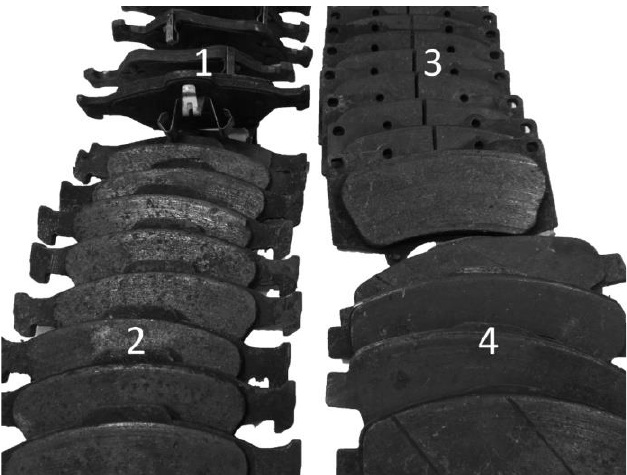
Figure 3. Examples of brake pads used for sampling: 1 — brake pads for small urban hatchbacks; 2 — brake pads for premium cars; 3 — brake pads for off-road vehicles; 4 — brake pads for delivery vans.